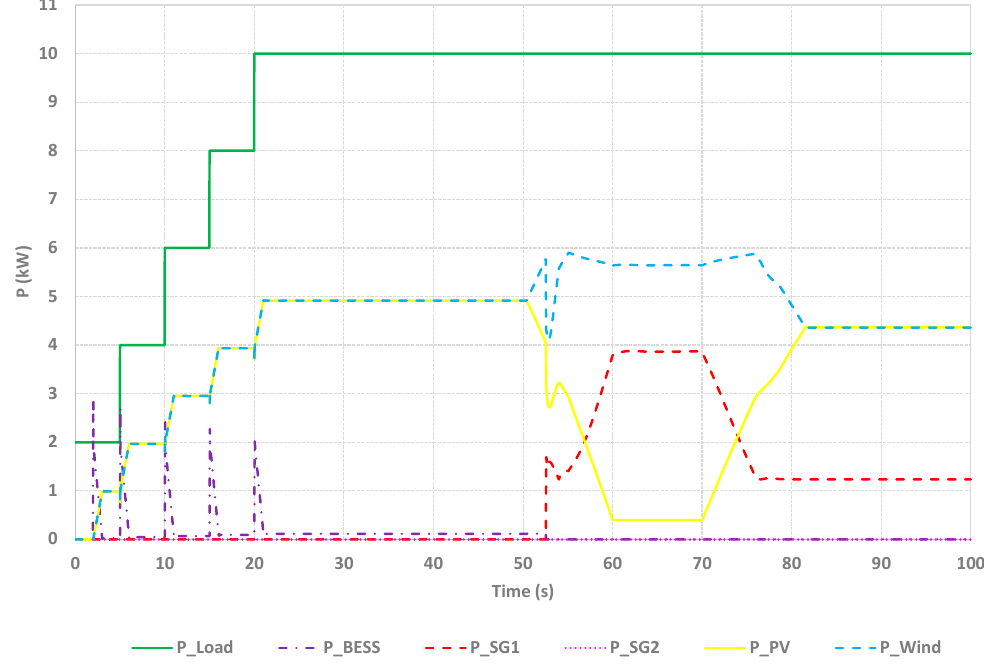
Figure 14. Scenario 3b: Cloud transient analysis for maximum solar PV and wind generation for a 10 kW demand with the BESS.